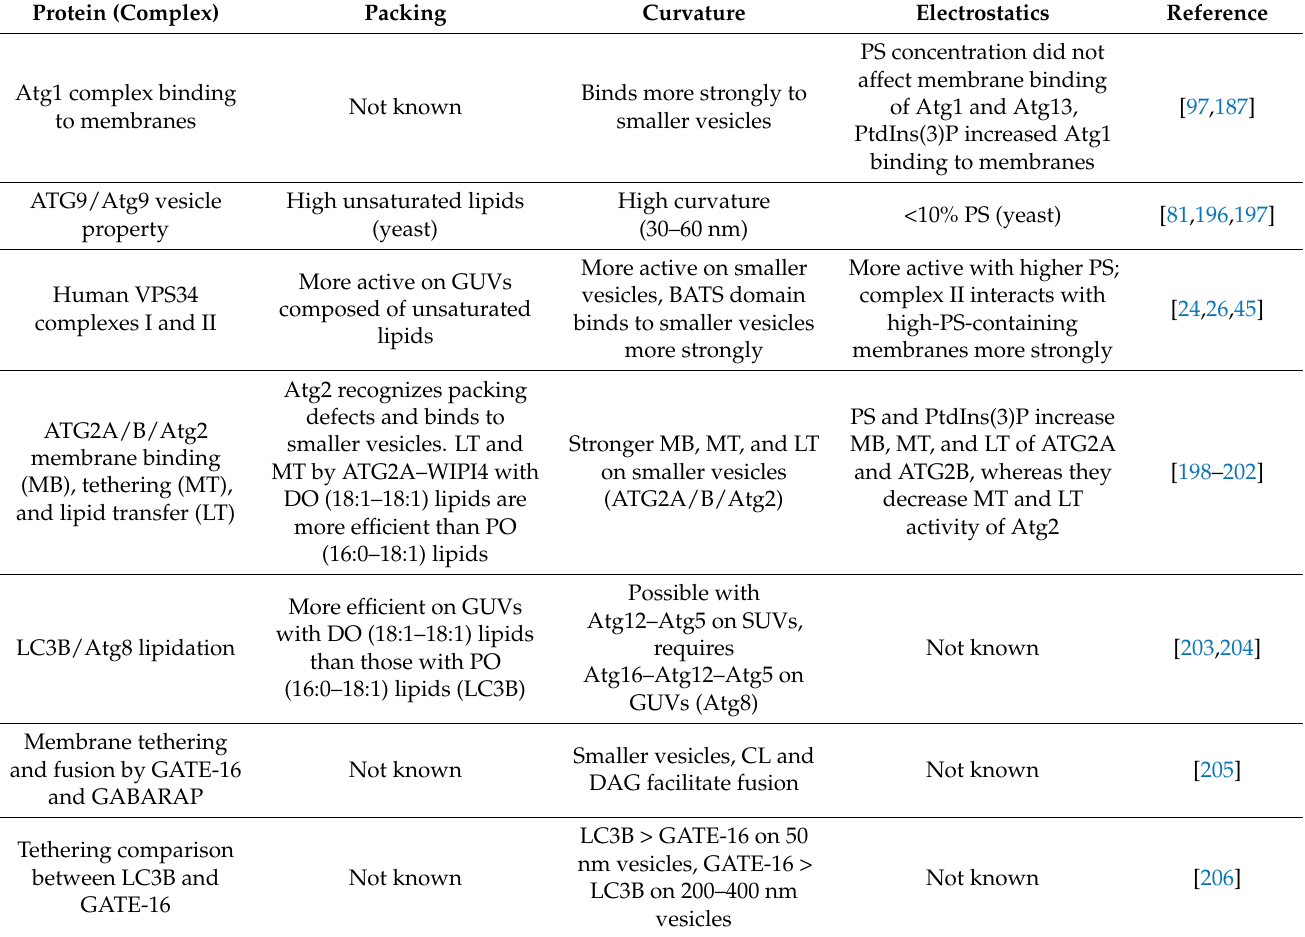
Table 1. Summary of effects of lipid physicochemical parameters on the activities and membrane binding of autophagy- related proteins. The lipid physicochemical parameters of ATG9/Atg9 vesicles are also involved. Protein (Complex) Packing Curvature Electrostatics